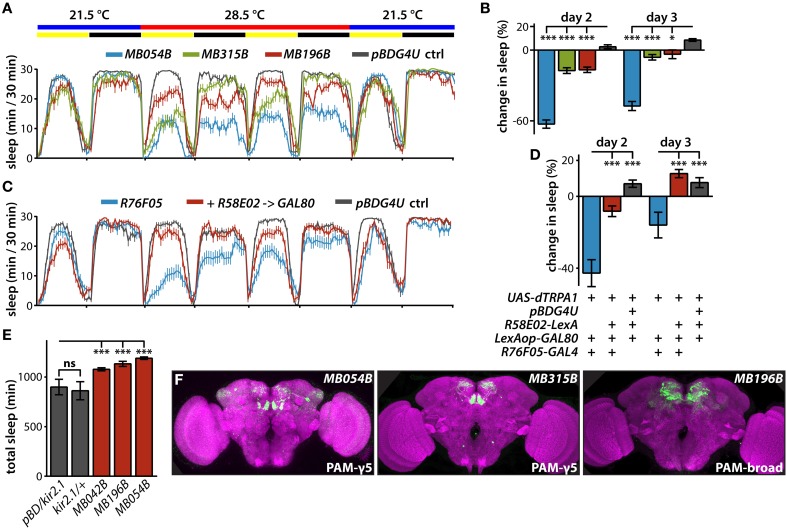
Sleep profiles of flies following thermogenetic activation of MB dopamine neurons. (A) Sleep profiles of male flies expressing dTRPA1 in PAM neurons driven by the indicated split-GAL4 lines (mean ± sem). Flies were maintained in 12 h:12 h light:dark (LD) conditions (indicated by the yellow and black bars, respectively), and the temperature was increased for days 2 and 3 of the 4 day experiment. DANs targeted by MB054B innervate the γ3 and γ5 compartments, MB315B the γ5 compartment, and MB196B multiple compartments. (B) Quantification of change in sleep of male flies expressing dTRPA1 in PAM neurons. Genotypes are color coded as in (A). Statistical analysis was by One-Way ANOVA and Dunnett's paired-comparison test. (C) Sleep profiles of male flies expressing dTRPA1 in PAM neurons driven by R76F05-GAL4 driver, with and without co-expression in PAM neurons of the GAL80 inhibitor of GAL4-mediated transcription driven by the R58E02-LexA driver, treated as in (A). (D) Co-expression of GAL80 in PAM neurons strongly suppresses wake induced by GAL4-mediated expression of dTRPA1. Genotypes are color coded as in (C); quantification and statistical analysis as in (B); n = 26–29 flies per genotype. (E) Expression of the hyperpolarizing kir2.1 K+ channel driven in PAM neurons by the indicated split-GAL4 lines increases total 1-day sleep. Quantification and statistical analysis as in (B); n = 30–32 flies per genotype. (F) Whole brains of flies expressing GFP under the control of indicated splitGAL4 drivers immunostained for GFP (green) and the synaptic neuropil marker BRUCHPILOT (purple). *p < 0.05; ***p < 0.001.